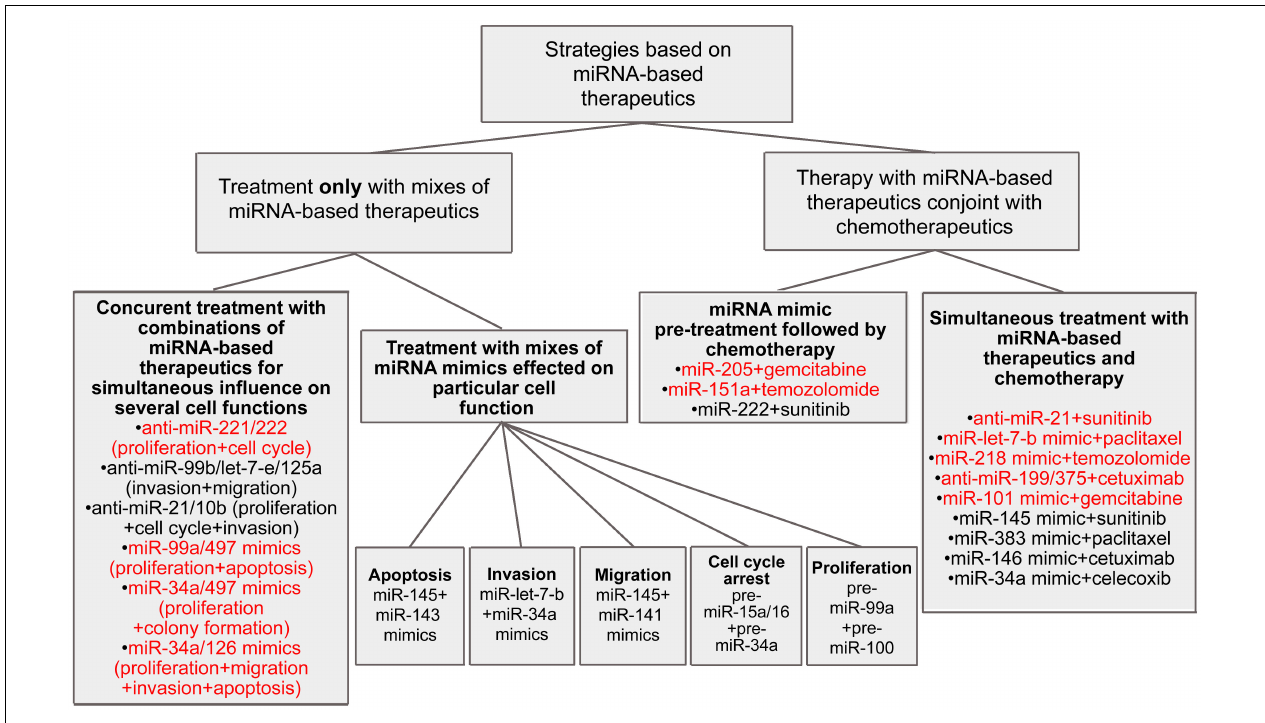
FIGURE 3 | Different combinative strategies to inhibit tumorigenesis. Mixes exhibited high efficiency in vivo are colored by